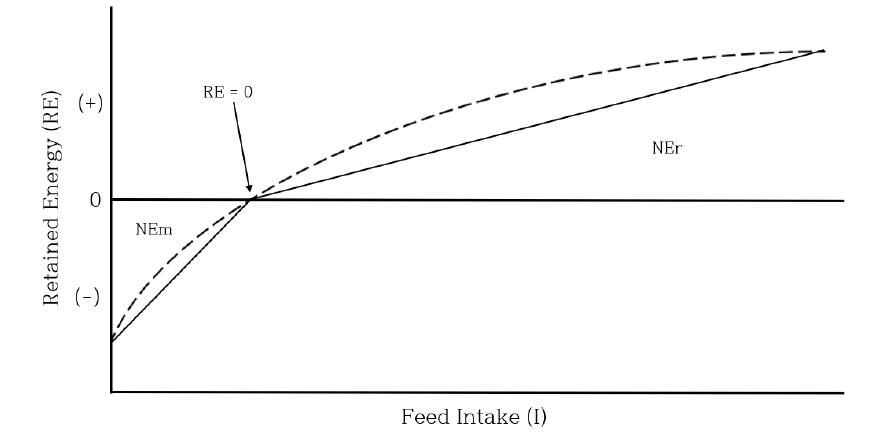
Figure 1. Relationship between RE (retained energy) and NE (net energy). The dashed line shows the curvilinearity and the solid lines are linear approximations (Adopted from [3]).